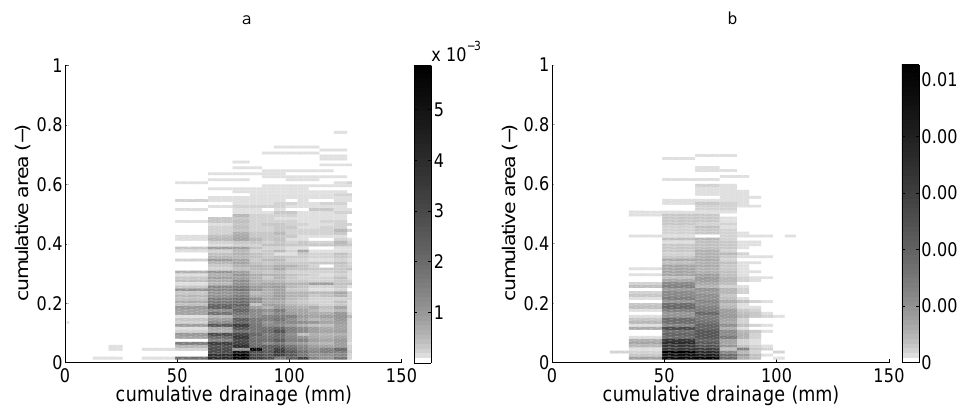
Fig. 4. Scaled solute flux density (d − 1 ) for the irrigation experiment. (a) Bromide, (b) Propylene glycol.